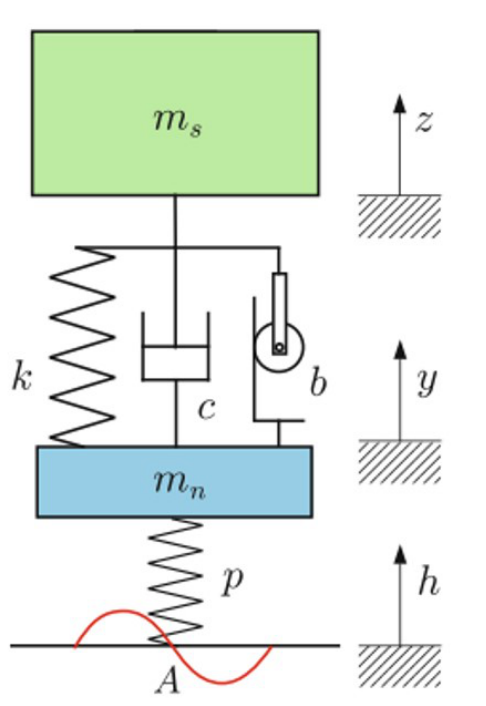
Figure 7. Quarter Car